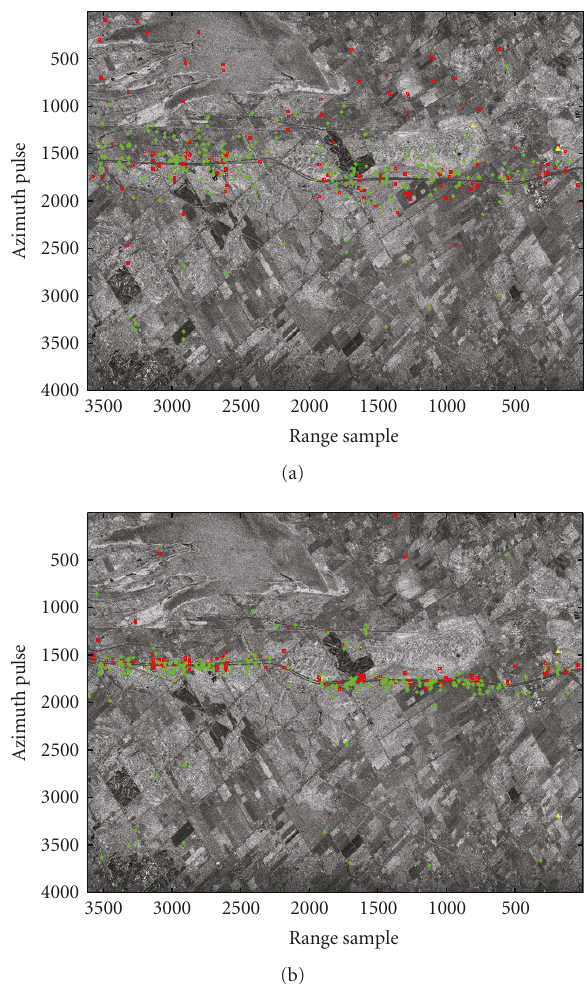
Figure 9: Comparison of azimuth position estimation, which is directly related to V tr estimation, with (b) and Without (a) clutter cancellation before forming the